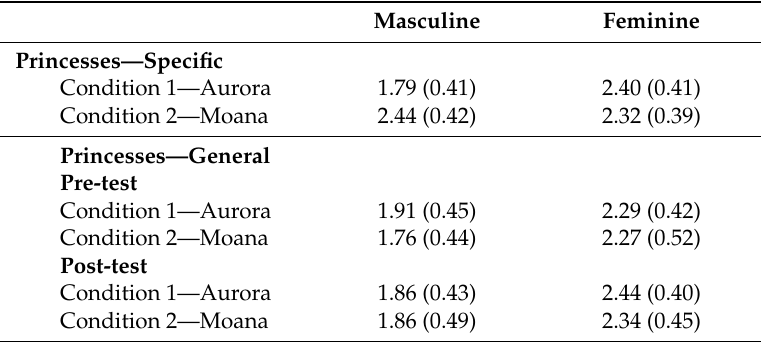
Table 1. Means (standard deviations) for the attribution of masculine and feminine characteristics to specific princesses viewed, and princesses in general.